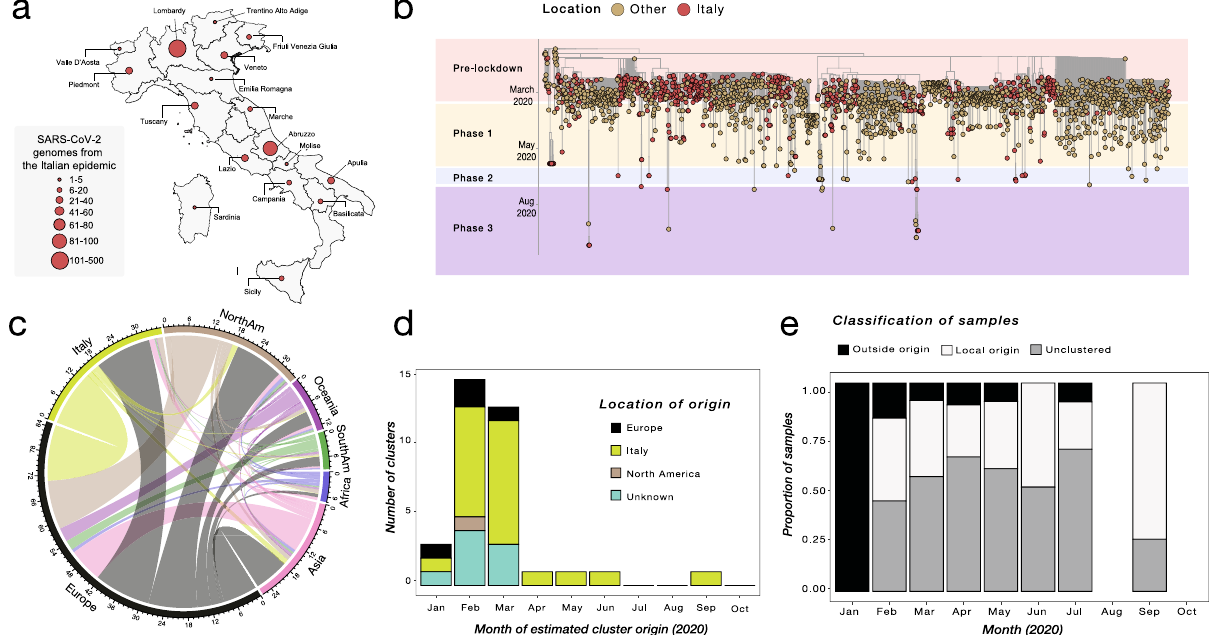
Fig. 3 Phylogenetic characterization of Italian SARS-CoV-2 sequences. a Map of Italy showing the number of SARS-CoV-2 genome sequences by region. The size of the circles indicates the number of new genomes available since the beginning of the epidemic in Italy. b Time-resolved maximum likelihood tree of 1421 SARS-CoV-2 sequences including 714 from Italy (red circles). c Chord diagram of estimated numbers of migration fl ows between the geographic areas. d Frequency of estimated geographical origins for identi fi ed transmission clusters involving Italy and originating in the months of January through October of 2020. e Frequency of Italian sequences (sampled from January through October) classi fi ed as unclustered (gray) or belonging to clusters with Italian (white) or non-Italian origins